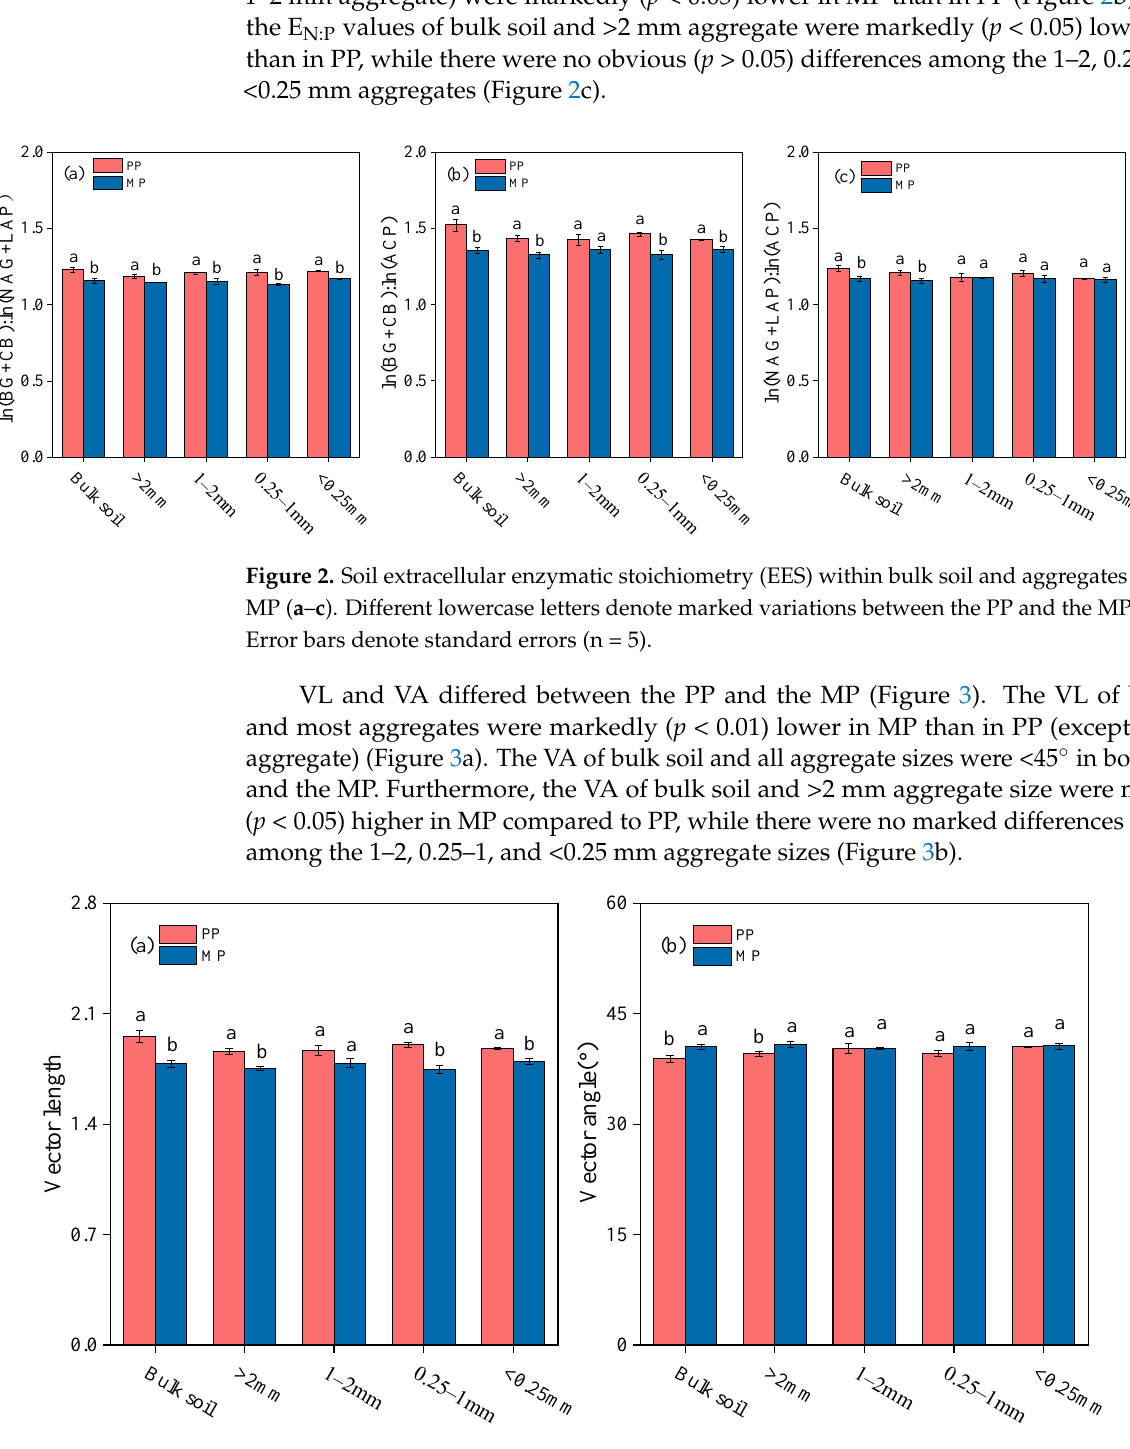
Figure 3. Vector length (VL) ( a ) and vector angle (VA) ( b ) in bulk soil and aggregates in PP and MP. Different lowercase letters denote marked variations between the PP and the MP ( p < 0.05). Error bars denote standard errors (n = 5).